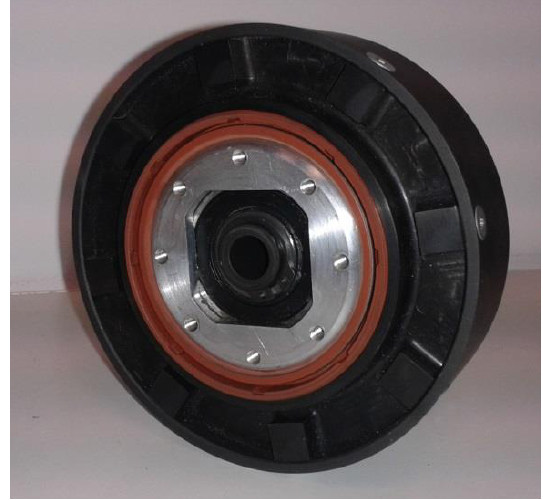
Figure 4. MAGSOAR TL-40 Magnetic Torque Limiter. Max. torque 40 Nm.